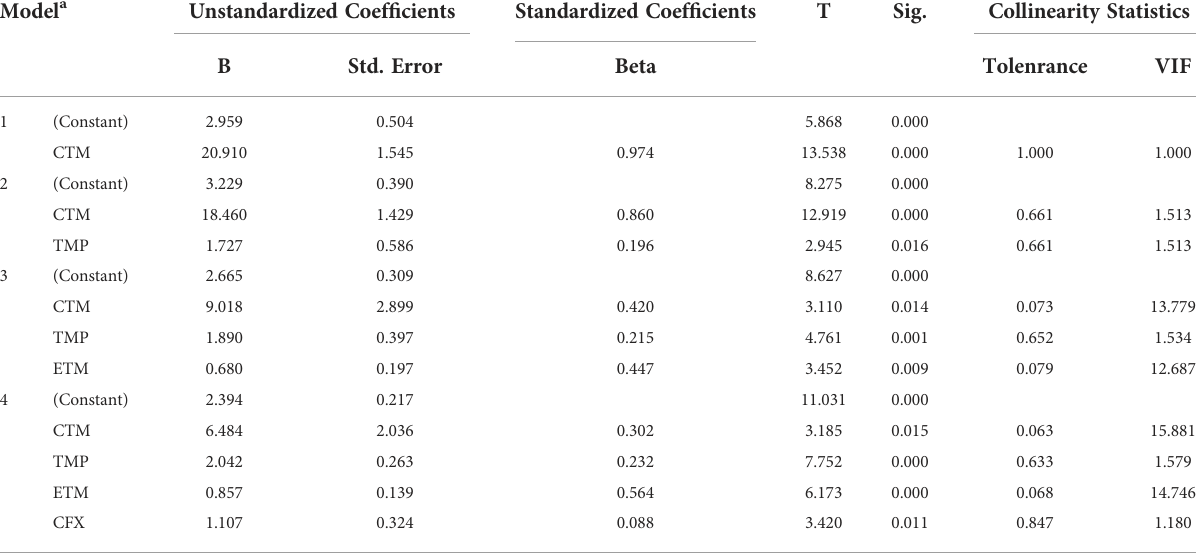
TABLE 4 The results of multiple linear regression analysis between antibiotics and environmental factors in sediment